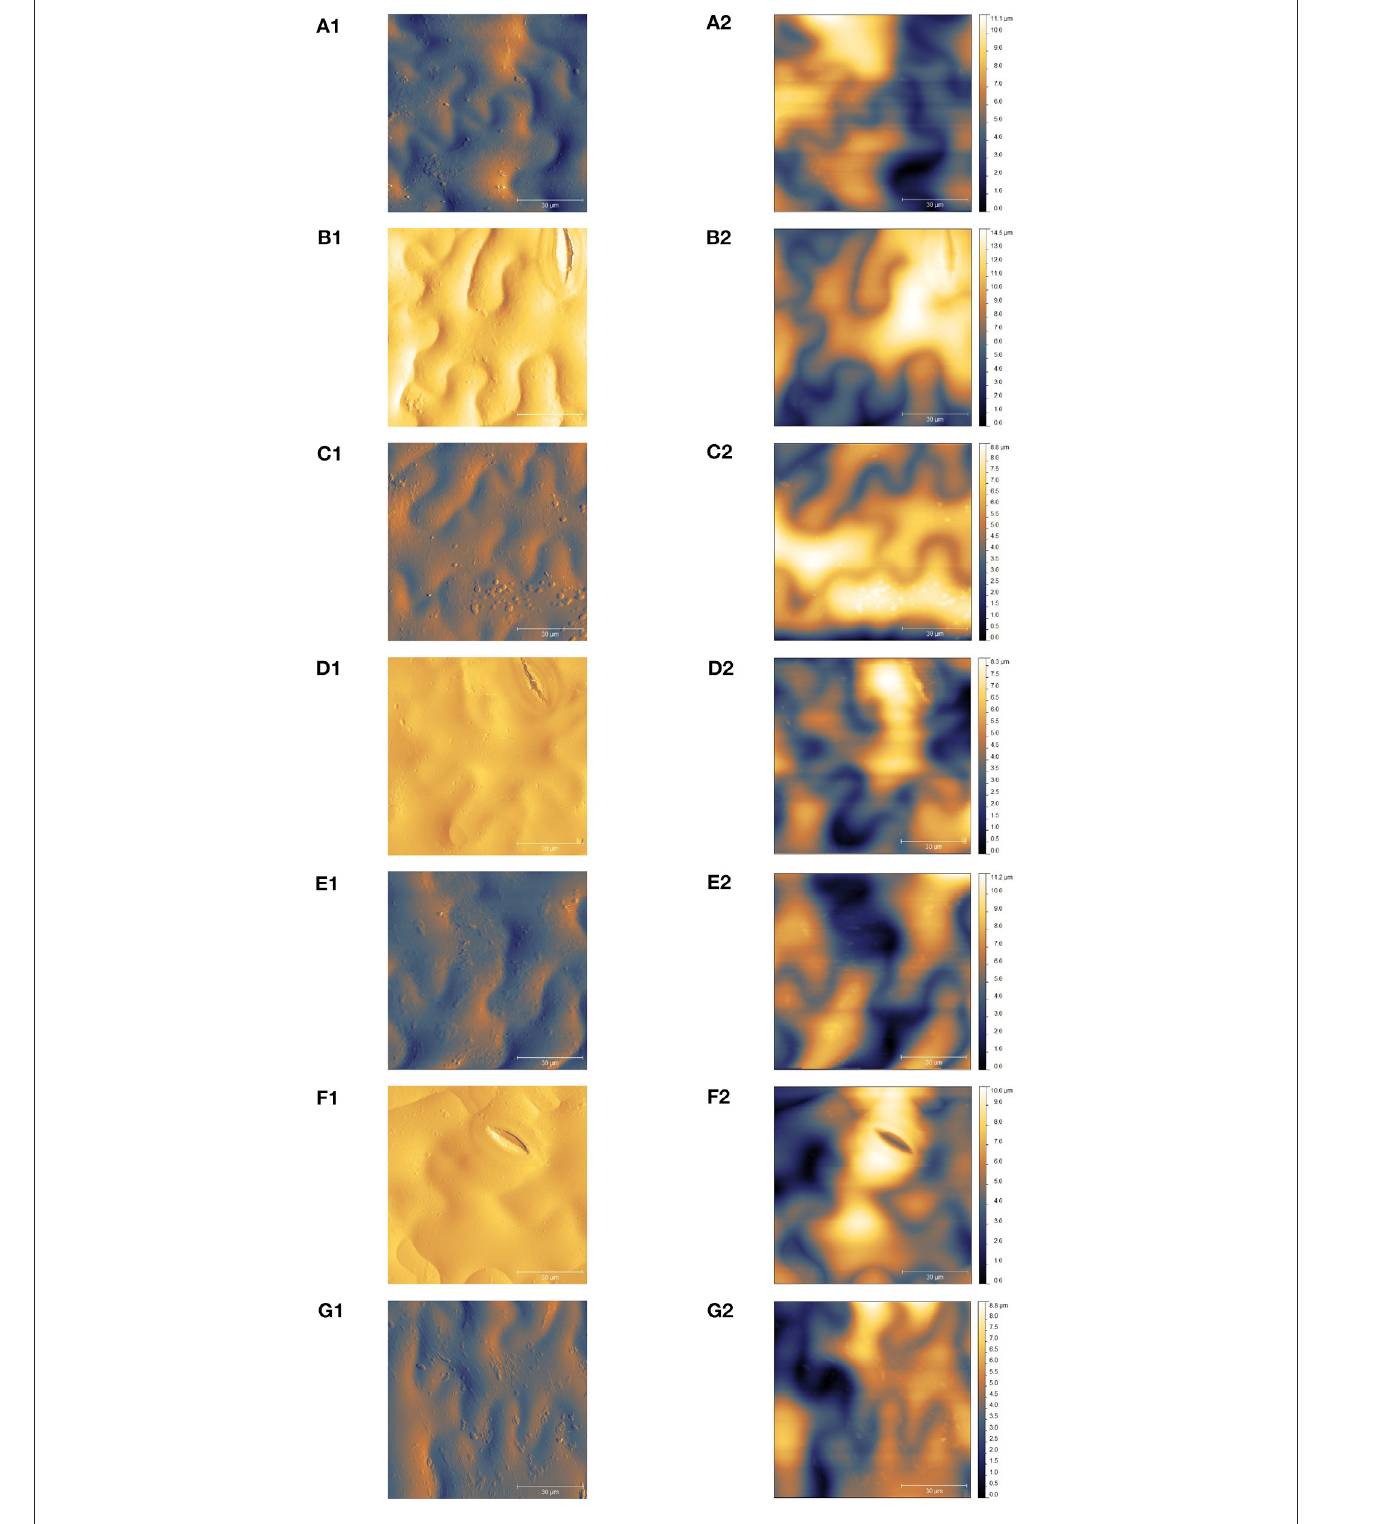
FIGURE 4 | Atomic force microscopy (AFM) of the fresh-cut lettuce. For each process variant (I–VI), two micrographs are shown: left—error signal/deflection micrograph, right—height micrograph. The variants shown are: (A) unwashed (extraction point 0), (B) tap water washed (variant I), (C) PTW washed—variant II, (D) PTW washed—variant III, (E) PTW washed—variant IV, (F) PTW washed—variant V, and (G) ClO 2 washed—variant VI.